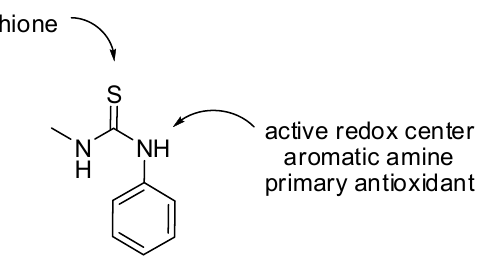
active redox center aromatic amine primary